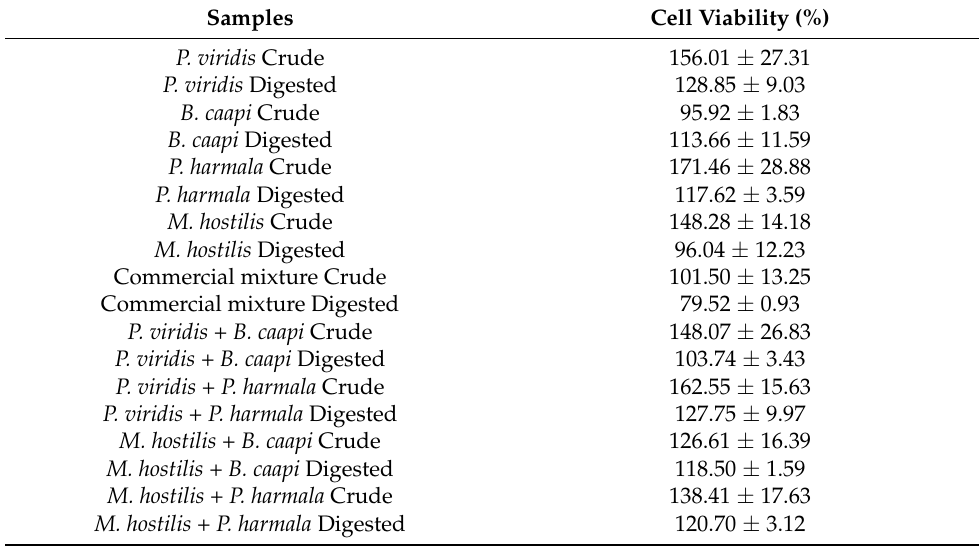
Table 3. Cell viability after exposure to extracts. The values are expressed as mean ± SD.